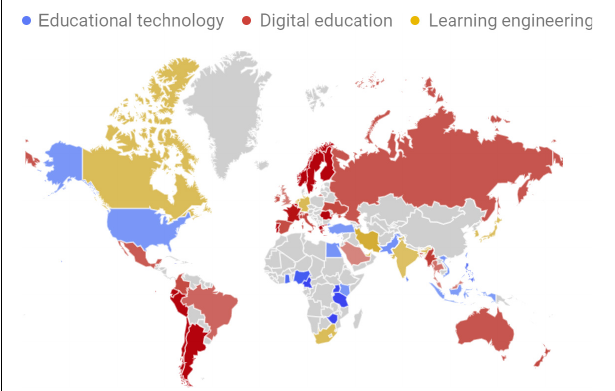
FIGURE 1 | Google search trends of competing terms by region (07/2010–07/2020). Data source: Google Trends (https://www.google. com/trends). Color intensity represents percentage of searches of most searched of the three terms (the higher the percentage, the more intense the color). Percentage means percentage of all searches of the three terms.